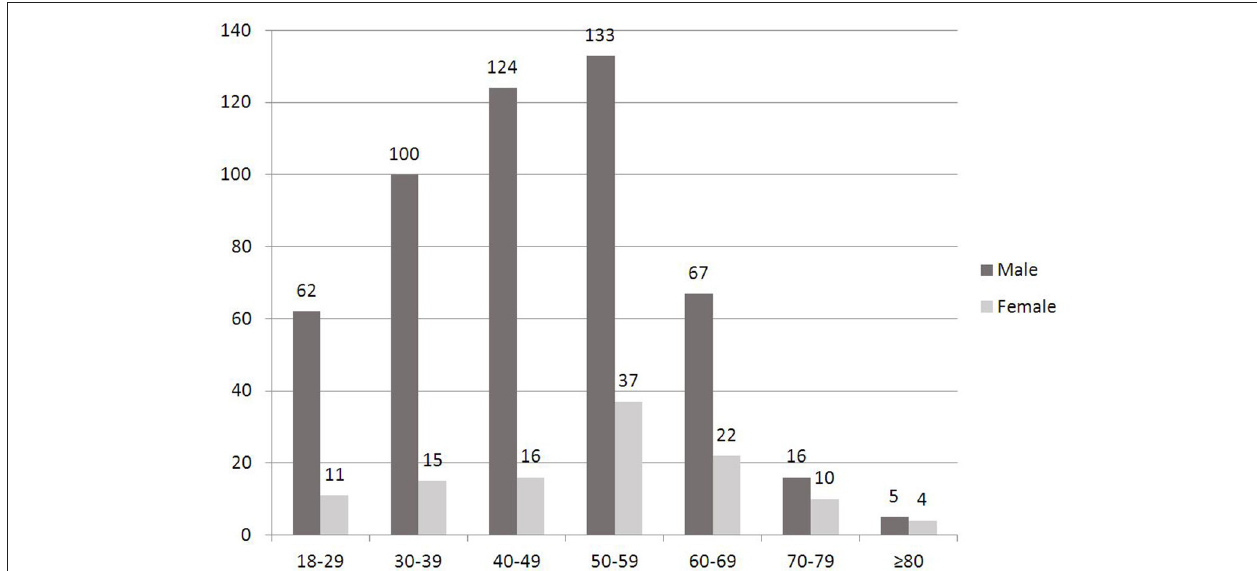
FIGURE 1 | Distribution of gender and age groups of severe adult opened globe injury patients.